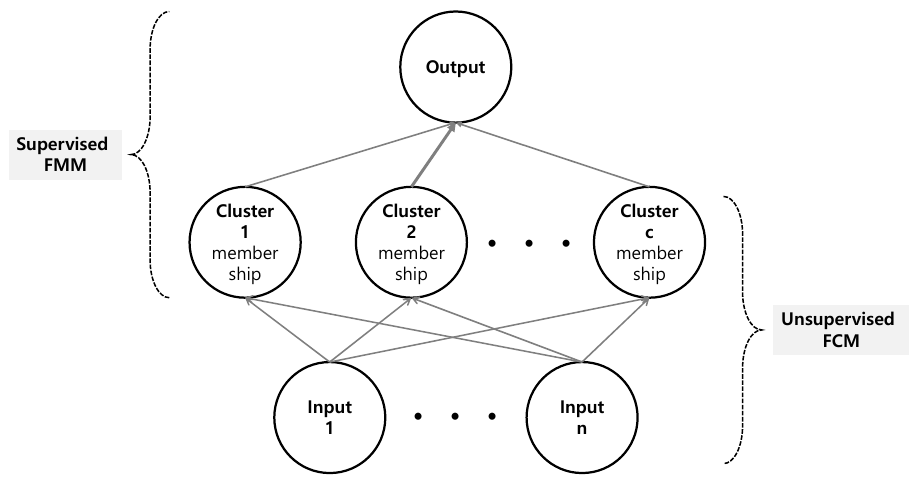
Figure 1. Structure of Proposed Method.